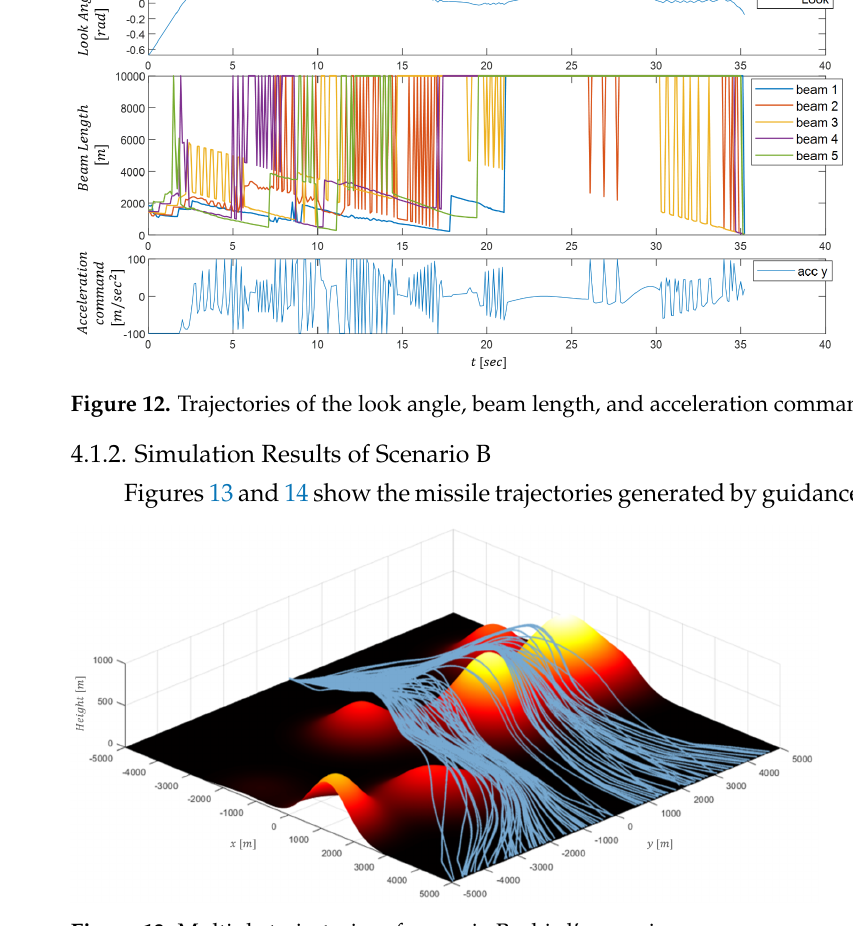
Figure 13. Multiple trajectories of scenario B—bird’s-eye view.